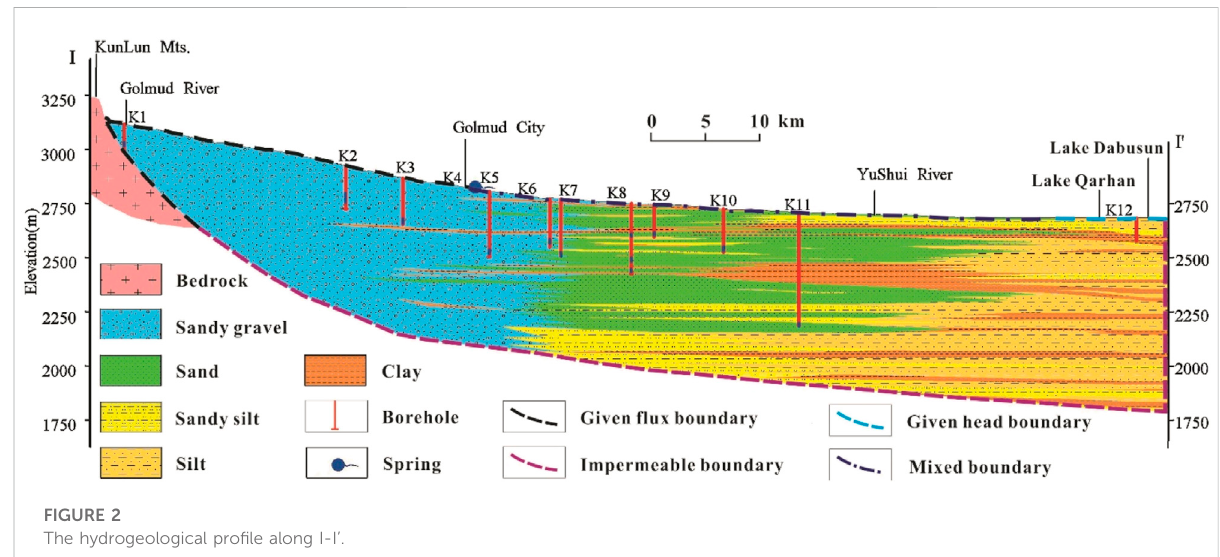
FIGURE 2 The hydrogeological pro fi le along I-I ’